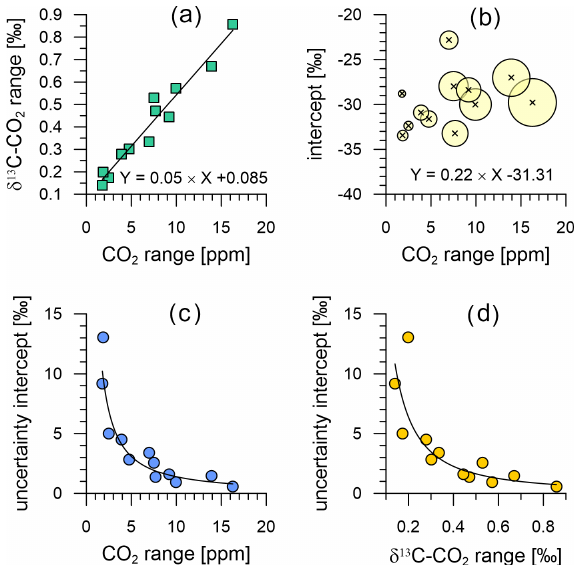
Figure 14. Relationship between the variations in CO 2 and δ 13 C- CO 2 of the 12 events used for KPA (a) , as well as their intercept as a function of the covered CO 2 range (b) . The bubble size in (b) scales with the range in δ 13 C-CO 2 covered within the KPA event. Uncertainty of the intercept (standard error) as a function of the range in CO 2 (c) and δ 13 C-CO 2 (d)